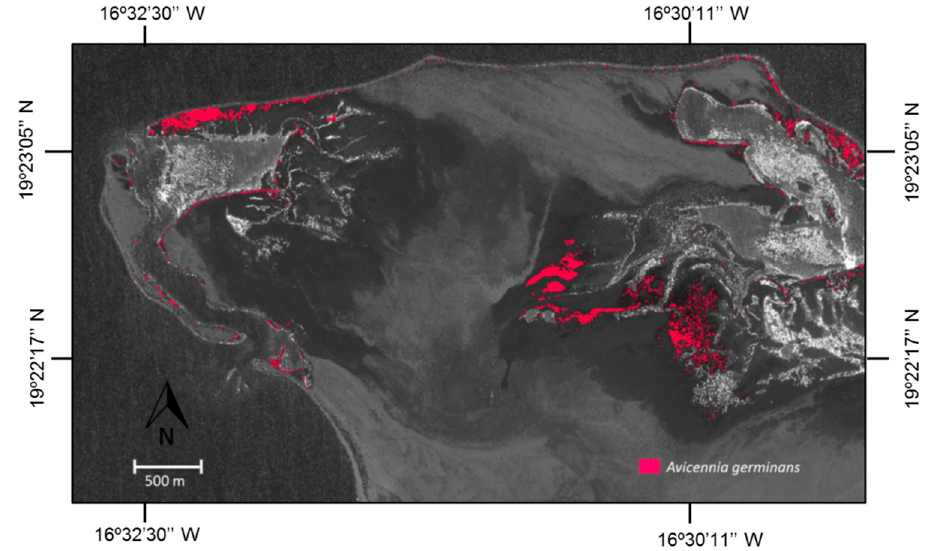
Figure 6. Mangroves at Cap Timiris, since mangroves in PNBA only comprise the mangrove species Avicennia germinans . There is an overestimation of mangroves in the central-east part of the area, mangroves are not found in that location.